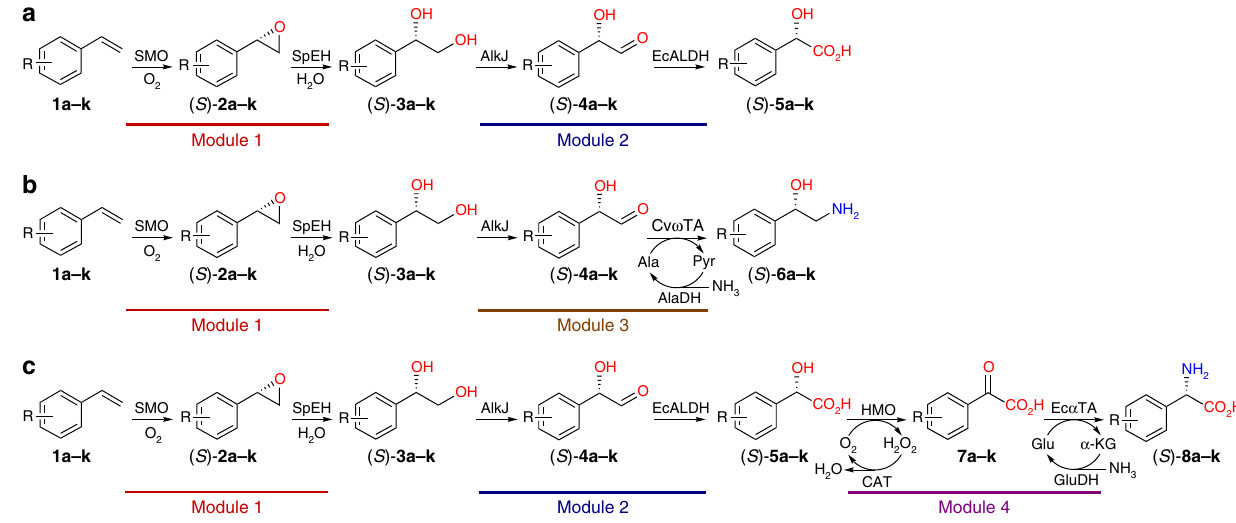
Figure 2 | Regio- and enantioselective multiple oxy- and amino-functionalizations of styrenes by modular cascade biocatalysis. ( a ) Conversion of styrenes to ( S )- a -hydroxy acids with E. coli strains containing enzyme module 1 and 2. ( b ) Conversion of styrenes to ( S )-1,2-amino alcohols with E. coli strains containing enzyme module 1 and 3. ( c ) Conversion of styrenes to ( S )- a -amino acids with E. coli strains containing enzyme module 1, 2 and 4. SMO: styrene monooxygenase from Pseudomonas sp. VLB120; SpEH: epoxide hydrolase from Sphingomonas sp. HXN-200; AlkJ: alcohol dehydrogenase from P. putida GPo1; EcALDH: phenylacetaldehyde dehydrogenase from E. coli ; Cv o TA: o -transaminase from C. violaceum ; AlaDH: alanine dehydrogenase from B. subtilis ; HMO: hydroxymandelate oxidase from S. coelicolor A3(2); Ec a TA: branch chain amino acid transaminase from E. coli ; GluDH: glutamate dehydrogenase from E. coli ; and CAT: catalase from E. coli